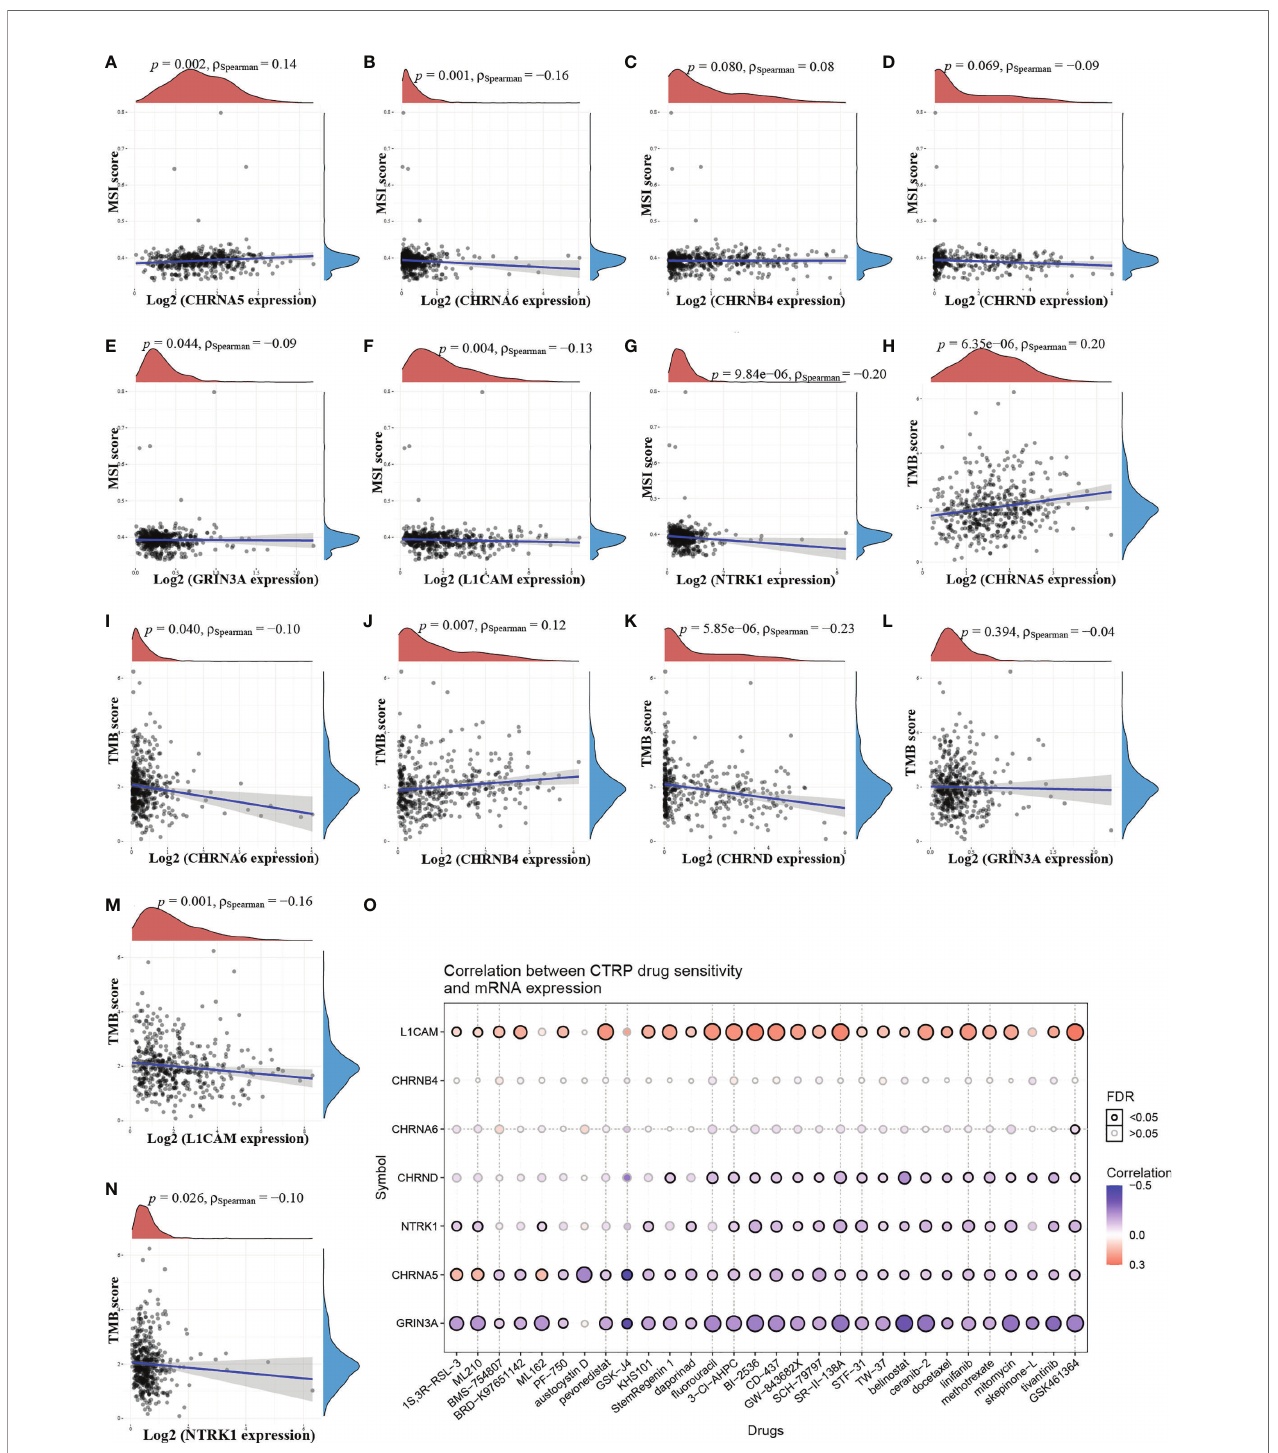
FIGURE 7 | The relationship between NCCGs and TMB, MSI, and drug sensitivity. The correlation between MSI and CHRNA5 (A) , CHRNA6 (B) , CHRNB4 (C) , CHRND (D) , GRIN3A (E) , L1CAM (F) , and NTRK1 (G) in HNSC. The correlation between TMB and CHRNA5 (H) , CHRNA6 (I) , CHRNB4 (J) , CHRND (K) , GRIN3A (L) , L1CAM (M) , and NTRK1 (N) in HNSC. (O) The correlation between seven prognostic NCCGs and drug sensitivity in CTRP database. TMB, tumor mutation burden; MSI, microsatellite instability; CTRP, cancer therapeutics response portal; NCCGs, nerve-cancer cross-talk genes; HNSC, head and neck squamous cell